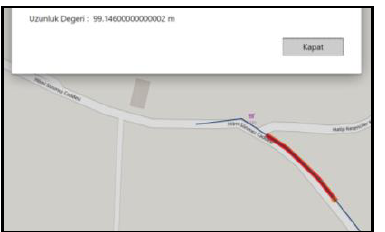
Figure 12. Approximate measurement of road disturbance record by measurement tool